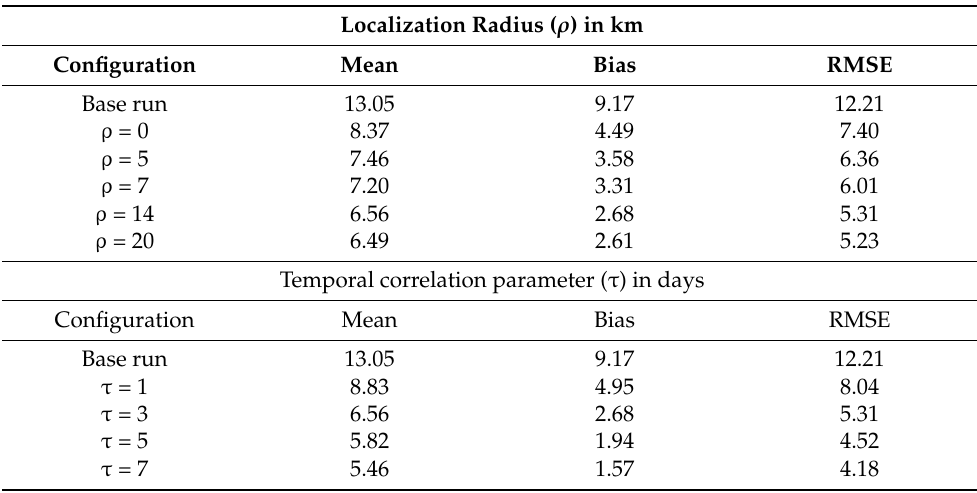
Table A1. Performance of the EnKF system for different parameters; the localization radius ( ρ ) and the temporal correlation parameter ( τ ). Hourly in situ measurements in the Koilada air quality station are compared with hourly surface simulations for July month. The statistics are given in µ g/m 3